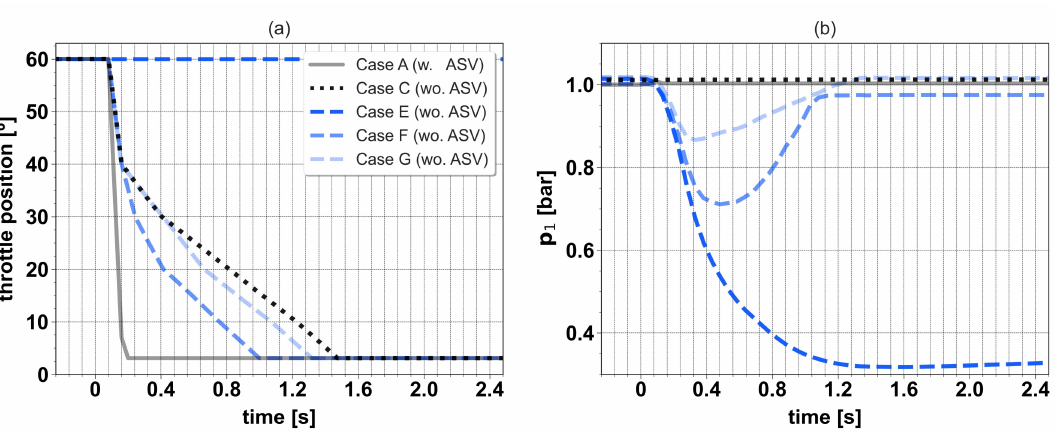
Figure 8. Throttle actuation ( a ) and time evolution of compressor inlet pressure ( b ) for Cases A, C, E, F, and